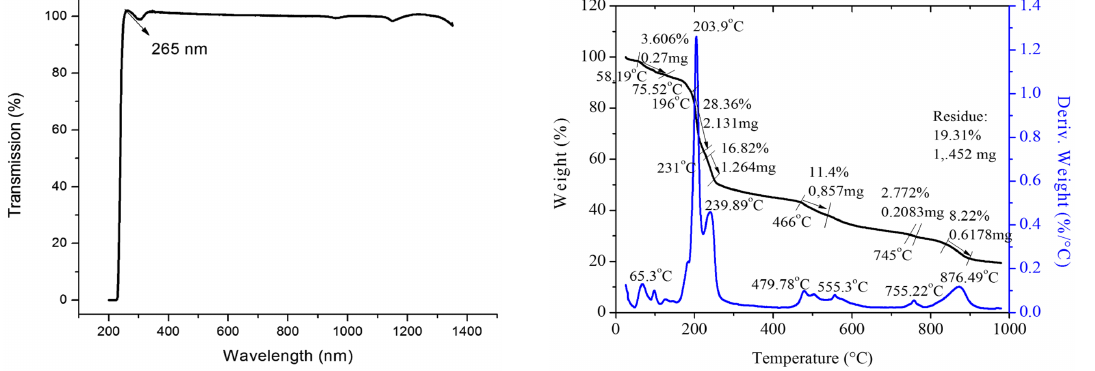
Figure 5. UV-Vis-NIR spectrum of LCHB crystal. Figure 6. TG-DTA curve of LCHB